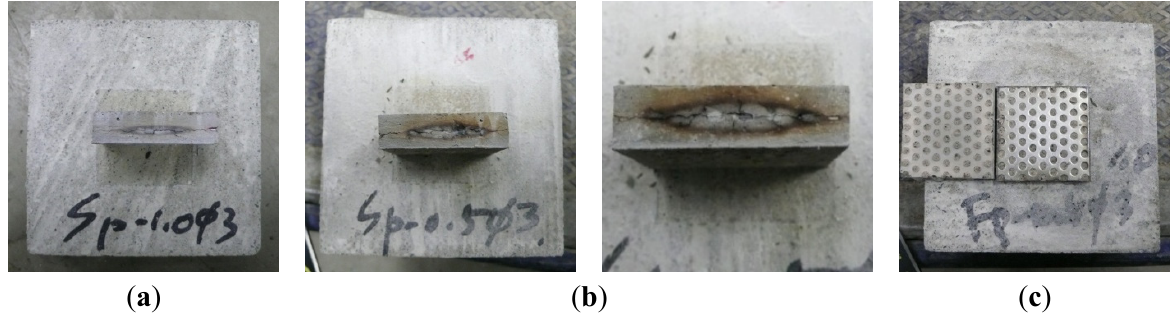
Figure 23. Heating of conductive resistor and weakening of the cementitious joint through induction heating. ( a ) Sp1.0–ø3 (2.25 kW, 30 s); ( b ) Sp0.5–ø3 (2.25 kW, 40 s); ( c )